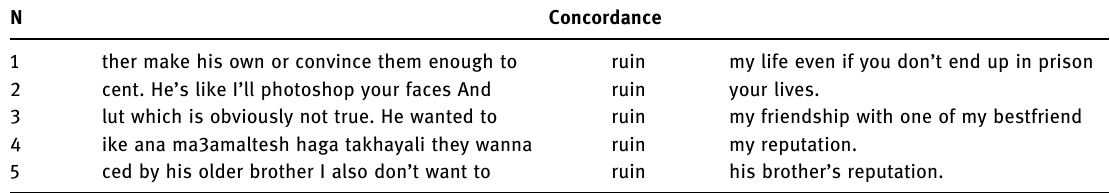
Table 39: Concordance lines for ruin